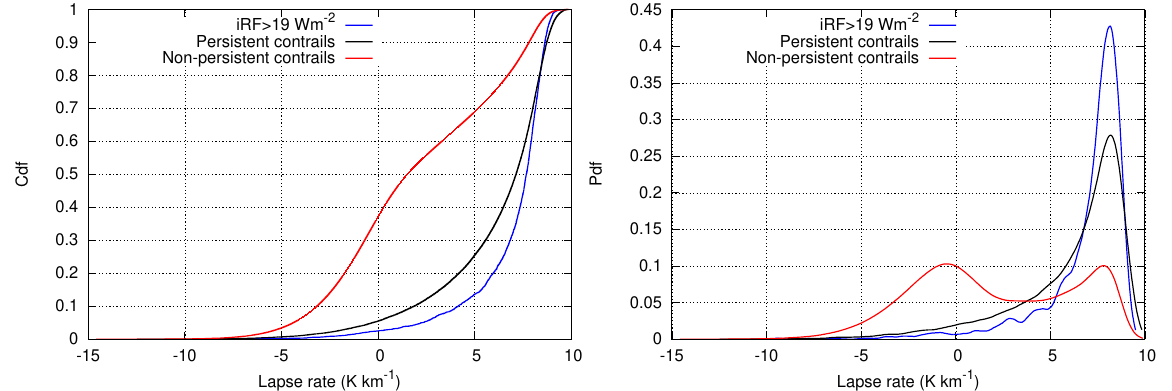
Figure 6. Left panel: cumulative distribution functions (cdfs) of lapse rates found in situations without persistent contrails (red), with persistent contrails (black), and with persistent contrails with large iRF (blue). Right panel: The probability density functions corresponding to the cdfs in the right